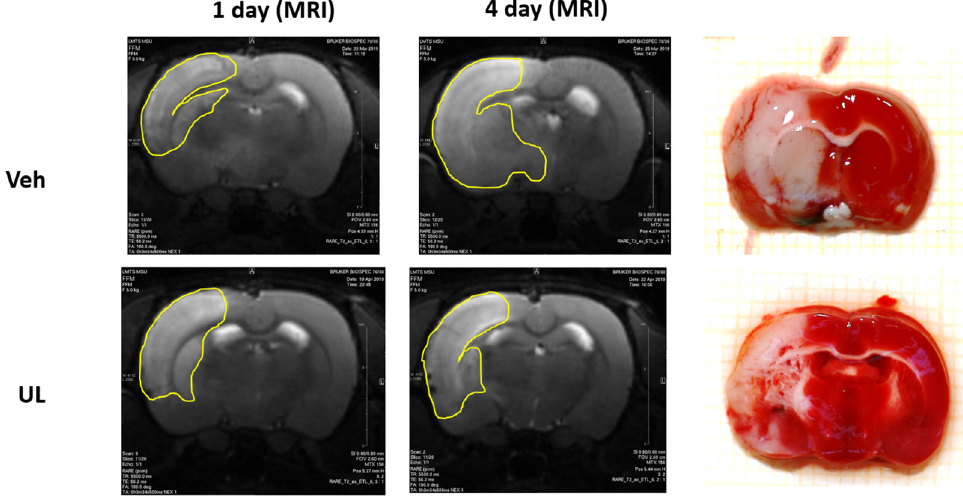
Figure 11. Dynamics of the brain lesion over four days and a comparison by MRI and TTC-staining. Veh–MCAO + Vehicle; UL–MCAO + Ubiquinol. The yellow line shows the area of brain damage. In the vehicle group, brain lesion was 48%, and did not significantly differ from the size of the damaged zone when assessed using TTC staining (39%). In the ubiquinol group, the damage zone by MRI analysis was 24.5%, and in the assessment of TTC staining, it was 22.7%. Thus, it can be assumed that the zone of brain damage by the 4th day after ischemia is represented mainly by necrosis, which